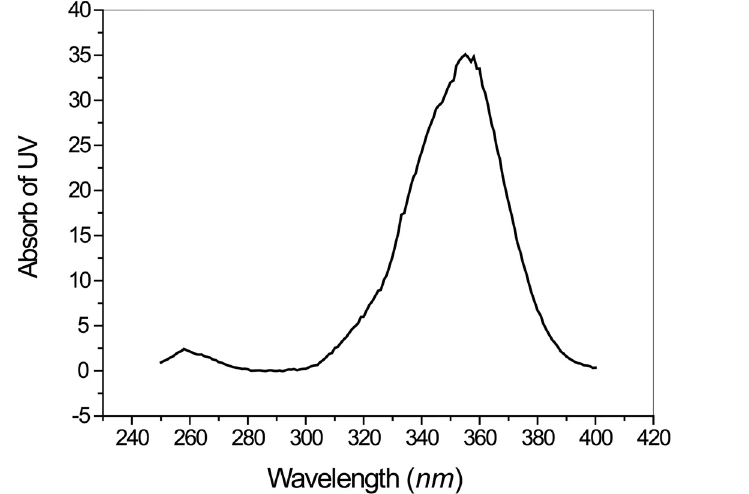
Fig 2. Ultraviolet-Visible (UV) Absorption Spectrum of BC-EDTA.